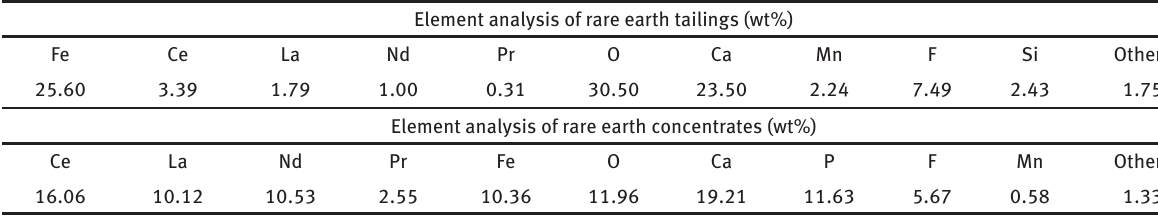
Element analysis of rare earth tailings